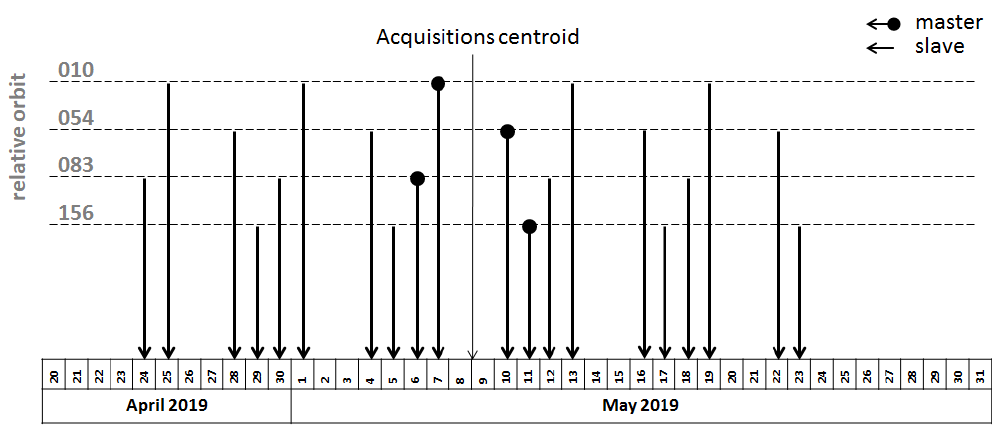
Figure 2. Sentinel-1 acquisition times description. A dot represents the master image, while the arrows represent the date of the slave images. The acquisitions centroid represents the average date among all the master acquisitions. Table 2. Sentinel-1 stacks description. From left to right: stack number, relative orbit number, name of the time-series associated to the orbit number, corner coordinates in latitude (Lat. min and Lat. max) and longitude (Lon. min and Lon. max). The stacks marked with an asterisk are chosen for the validation, while the others are used for training the Random Forests